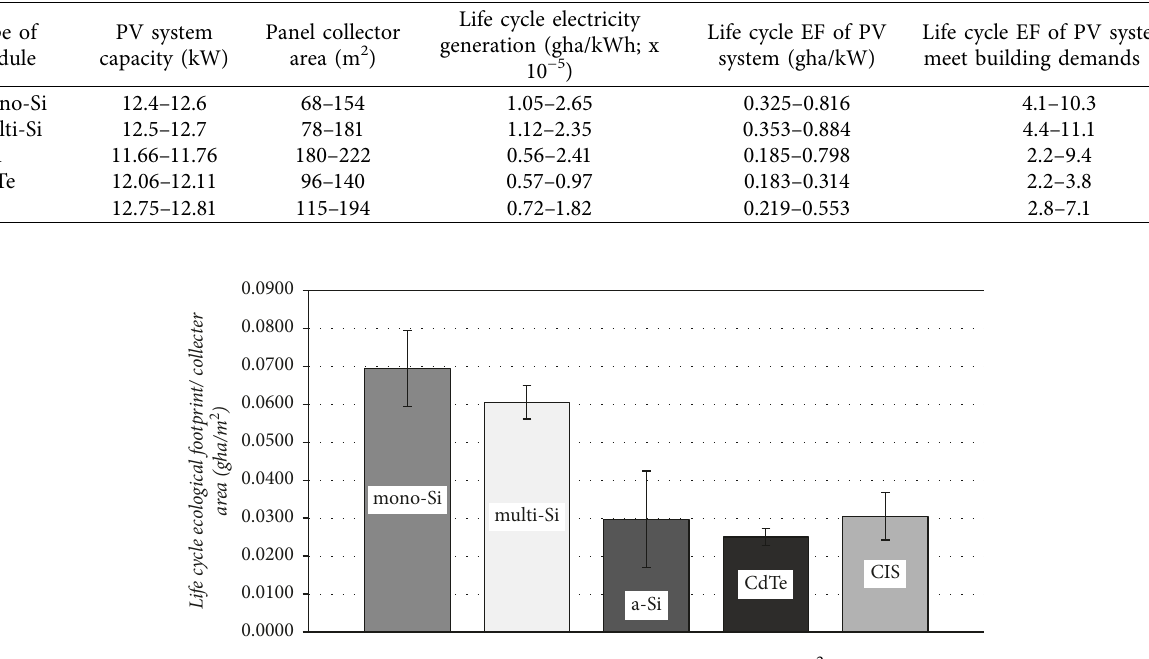
Table 14: EF assessment of different types of module-based PV systems for the case building.